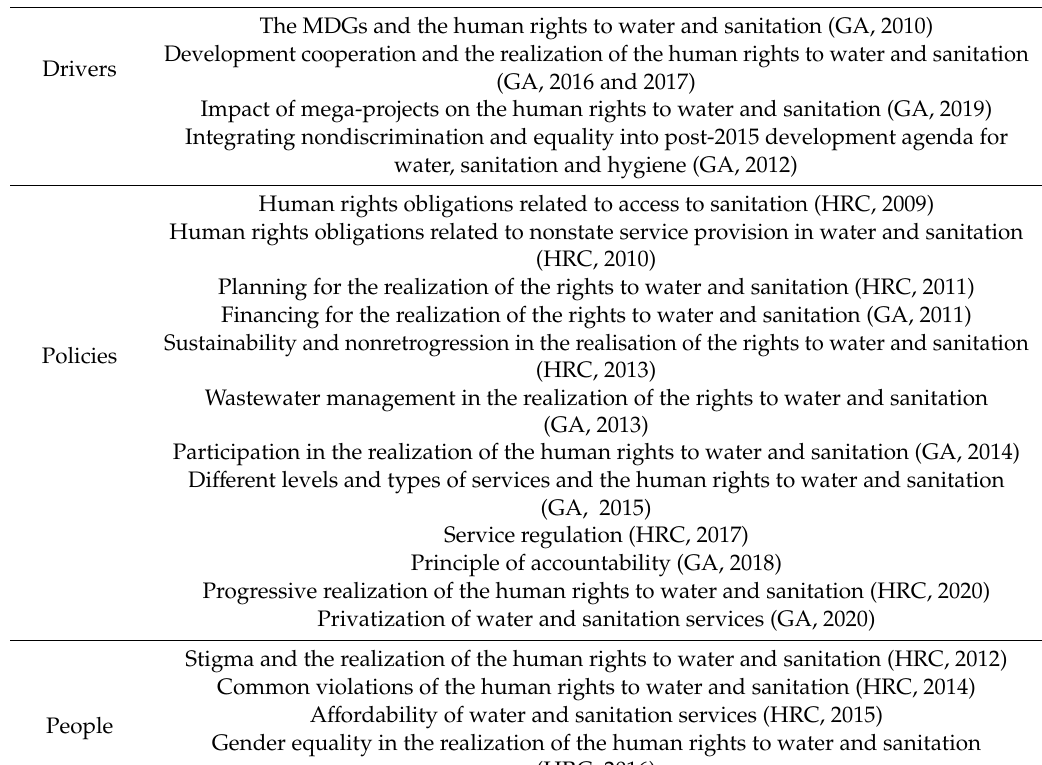
Table 1. Classification of the thematic reports of the SRs, according to the drivers-policies-people framework; (GA, presented to the General Assembly; HRC, presented to the Human Rights Council; year).